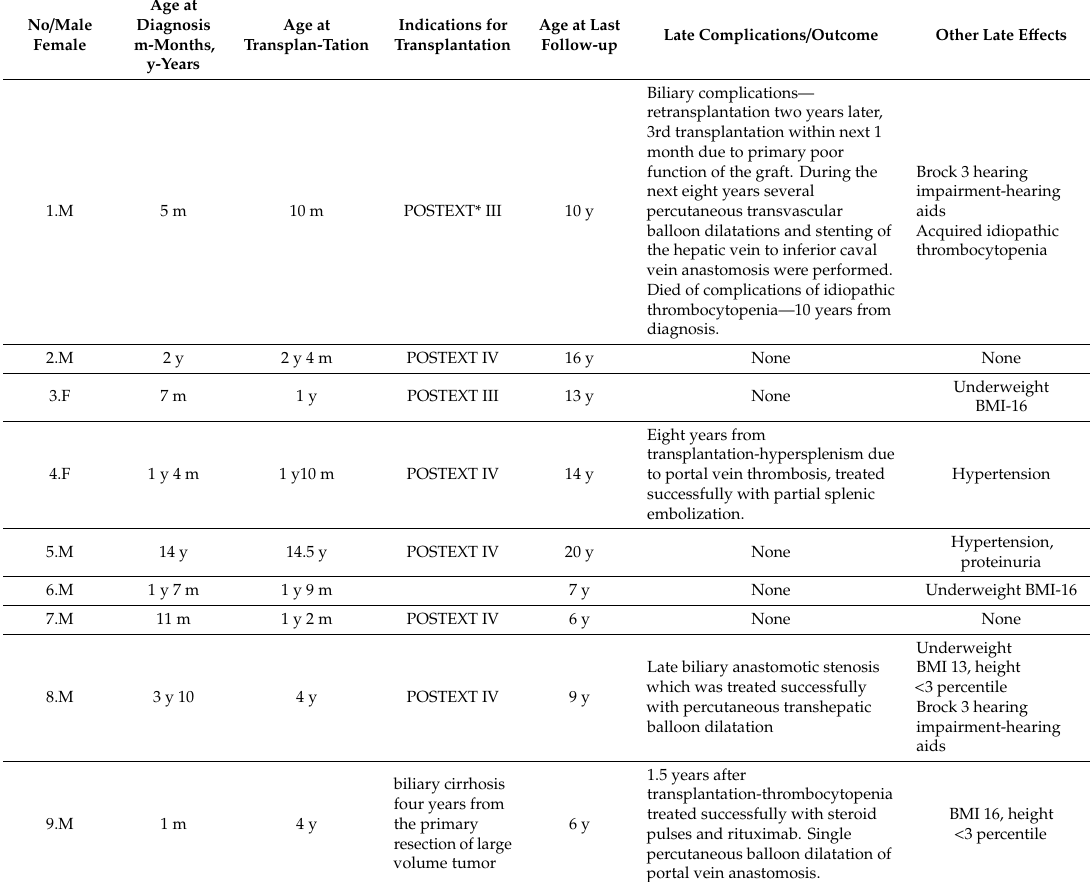
Table 1. Characteristics of patients treated with liver transplantation (n =